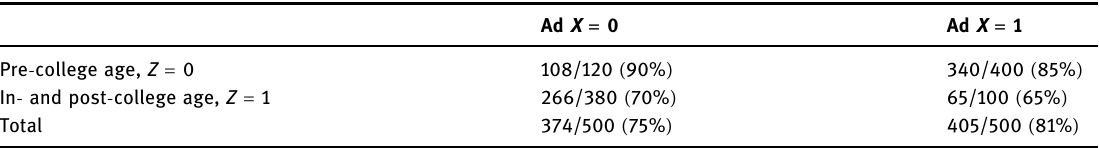
Table 2: Clickthroughs in the AdBot setting striated by the ad shown to participants in a focus group, and the age partition of the